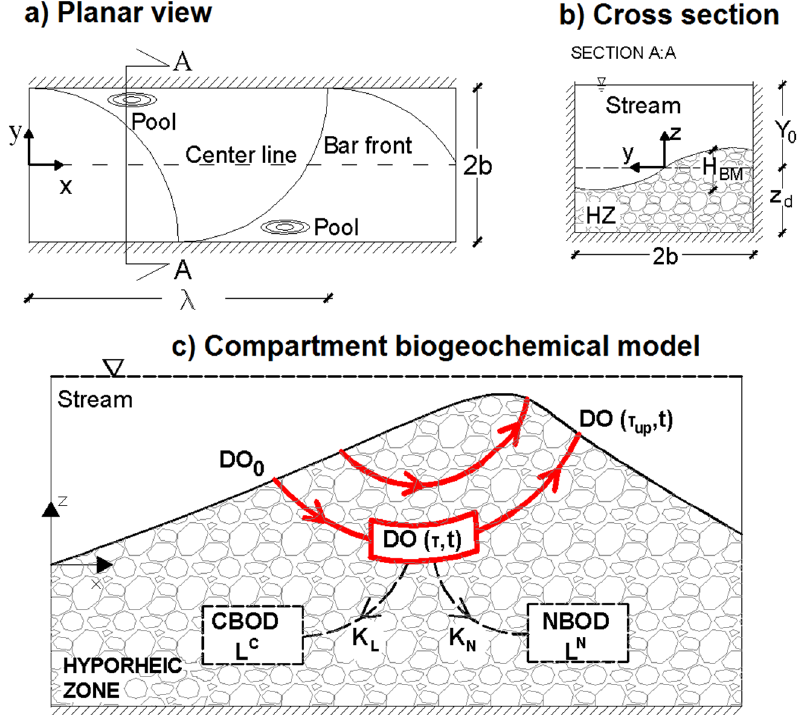
Figure 1. Sketch of ( a ) the planar view and ( b ) the cross-section of the three-dimensional alternate bar morphology; and ( c ) diagram of the biogeochemical model. DO, dissolved oxygen; CBOD, carbonaceous biological oxygen demand; NBOD, nitrogenous biological oxygen